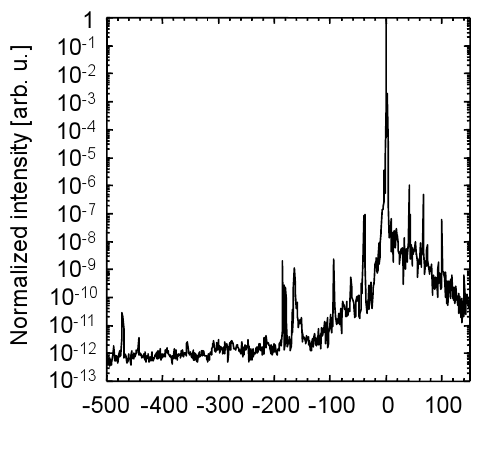
Figure 10. Contrast of the recompressed